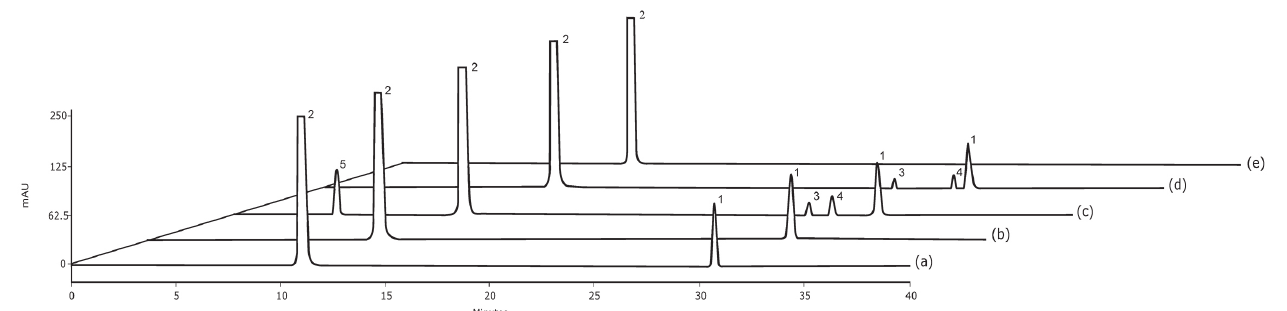
FIGURE 1 – Representative RP − LC chromatograms showing peak 1 = rhIFNβ − 1b; peak 2 = human serum albumin; peaks 3 and 4 = related proteins; peak 5 = hydrogen peroxide. (a) Biological reference substance of rhIFNβ − 1b. (b) Sample of biopharmaceutical formulation, untreated and after: (c) degradation by hydrogen peroxide; (d) photodegradation; (e)